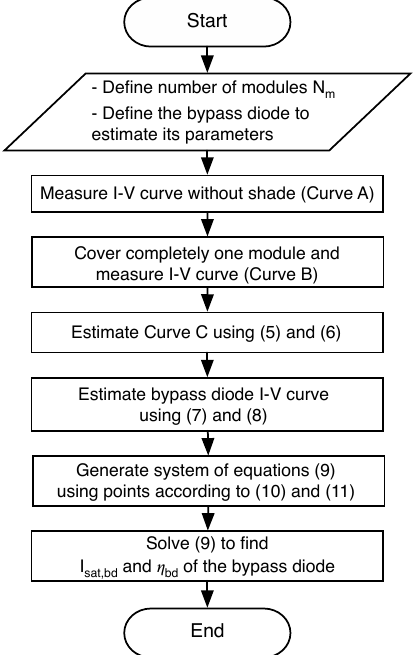
Figure 7. Flowchart of the proposed procedure to estimate η bd and I sat , bd in a selected bypass diode of a PV module formed by N m submodules connected in